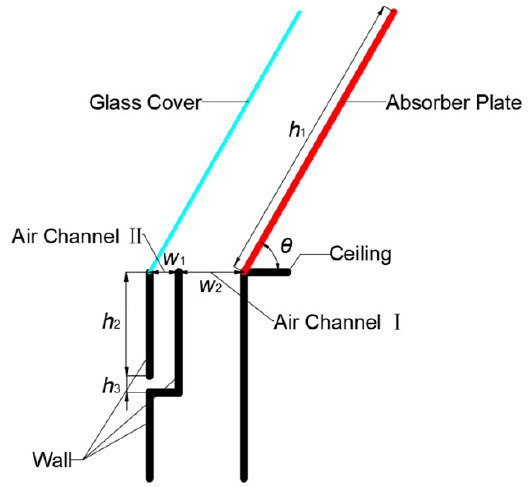
Figure 1. Physical model of the roof solar chimney.